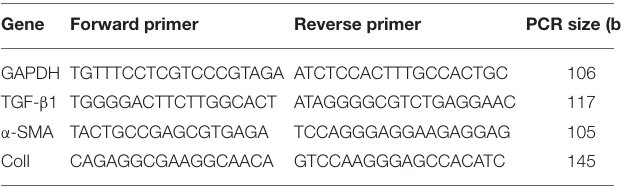
TABLE 1 | List of primers used for quantificational real-time polymerase chain reaction (qRT-PCR).